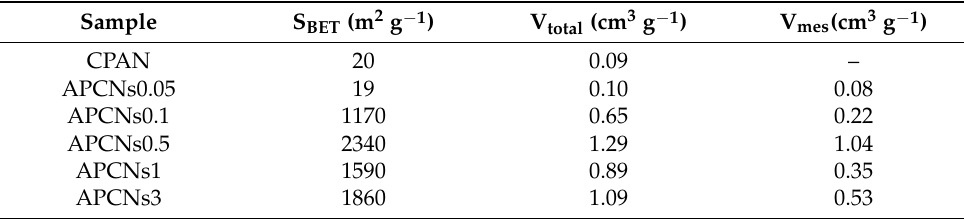
Table 5. Pore characteristics of porous carbon materials prepared at different KOH and OPAN mass ratios.